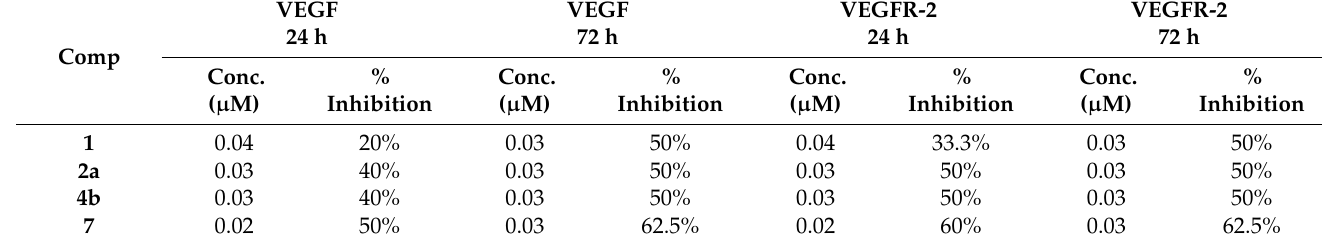
Table 4. Drugs and references lead compound effects in the MCF-7 cell line compared to the control using ELISA as the percentage of inhibition.